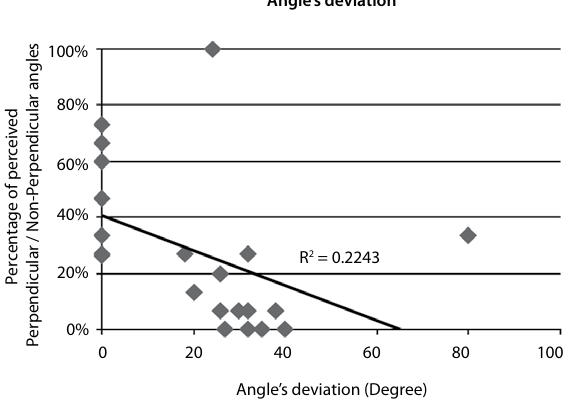
fig. 10. Comparison chart between street angles and percentage of perceived streets in Kenmore and Kendall